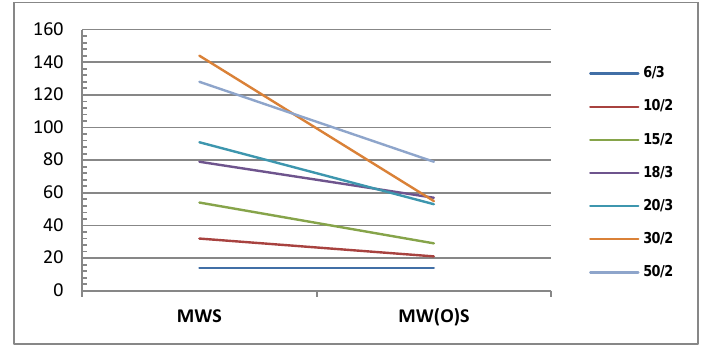
Fig. 18. Impacts of Activity Splitting Ability on Minimizing Cmax in Studied Cases